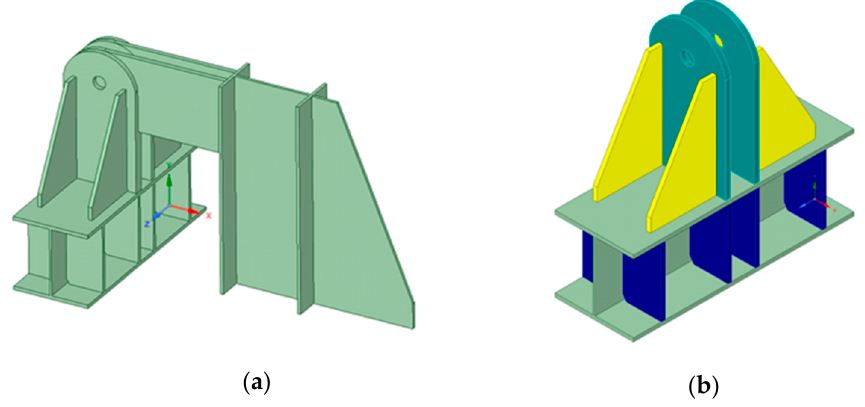
Figure 4. Supports utilized in the assembly: ( a ) Support restricted for translations in the plane and out-of-plane; and ( b ) support restricted for vertical translation and out-of-plane translation.